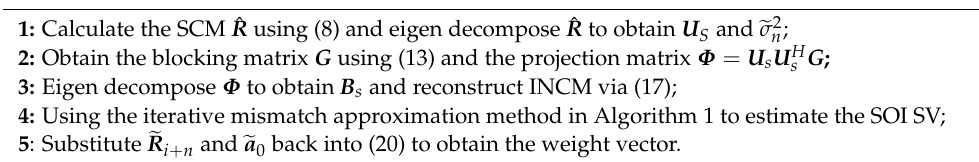
Algorithm 2. Proposed RAB